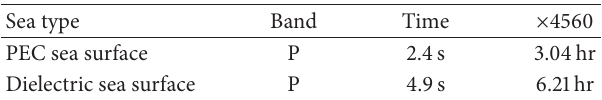
Table 2: Comparisons of CPU time of different types of underlying sea surface at our P-band.